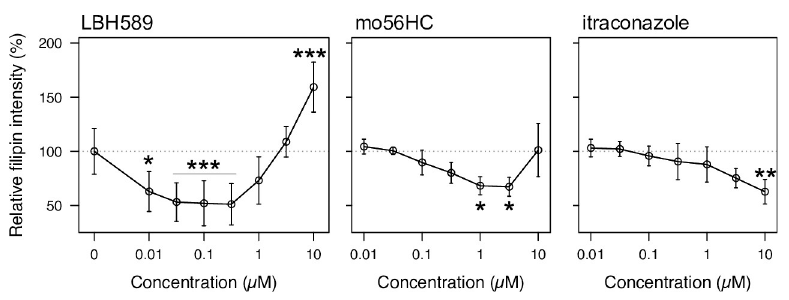
Fig 7. Effect of itraconazole on cholesterol accumulation in NPC fibroblasts bearing I1061T mutation. NPC fibroblasts (GM18453, NPC1 I1061T/I1061T ) were treated with the indicated compounds for 48 h and cholesterol accumulation was evaluated by means of filipin staining. The extent of cholesterol accumulation was quantified as fractional filipin intensity within filipin-positive puncta over total filipin staining intensity within cells. Statistical significance was evaluated by applying Dunnett’s multiple comparison test (two-sided) with adjusted p value (single- step method) presented as � p < 0.05, �� p < 0.01, and ��� p < 0.001 versus vehicle, after confirming normality and variance homogeneity by means of the Shapiro-Wilk test and Bartlett test. Error bars represent means ± SD from n = 3 (for LBH589) or n = 4 (vehicle, mo56HC, and itraconazole) independent experiments.